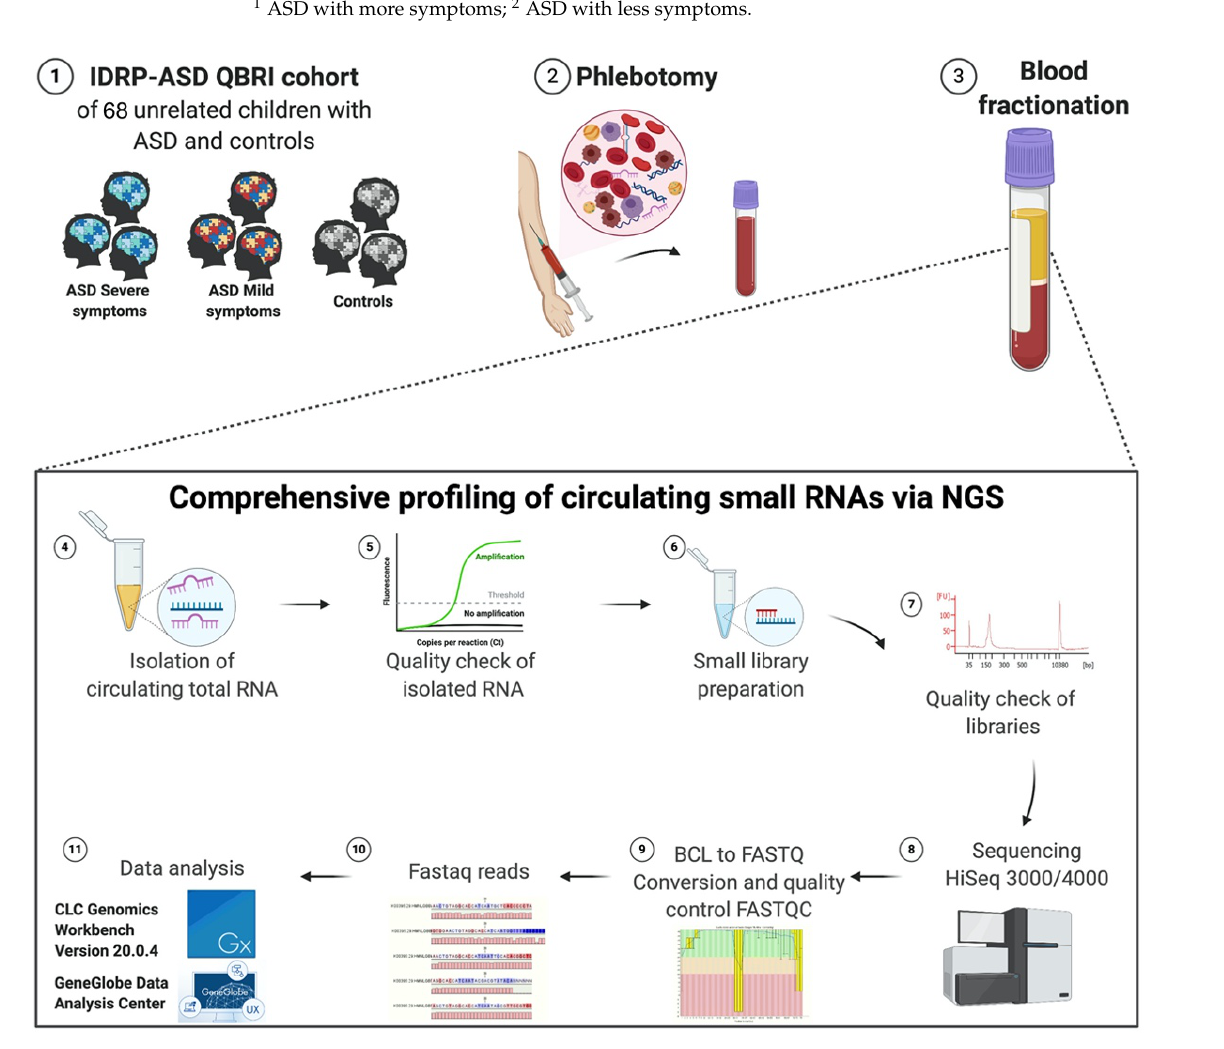
Figure 1. An overview of the experimental design of the study. ( 1 ) Sample selection; ( 2 ) Phlebotomy; ( 3 ) Blood fractionation; ( 4 ) RNA extraction and elimination of contaminants; ( 5 ) Assessment of isolated RNA and quality check using qRT-PCR; ( 6 ) Small library preparation; ( 7 ) Library quantifica- tion and assessment using bioanalyzer and Qubit; ( 8 ) Sequencing of libraries using NGS technology HiSeq 3000/4000 Illumina sequencing system. ( 9 ) BCL2 to Fastaq conversion and generation of Fastqc files. cDNA synthesis for small RNA without fragmentation; ( 10 ) Fastaq reads; ( 11 ) Data analysis using CLC Genomics Workbench program version 20.0.4 and Geneglobe Data analysis cen- ter. Created with BioRender.com.